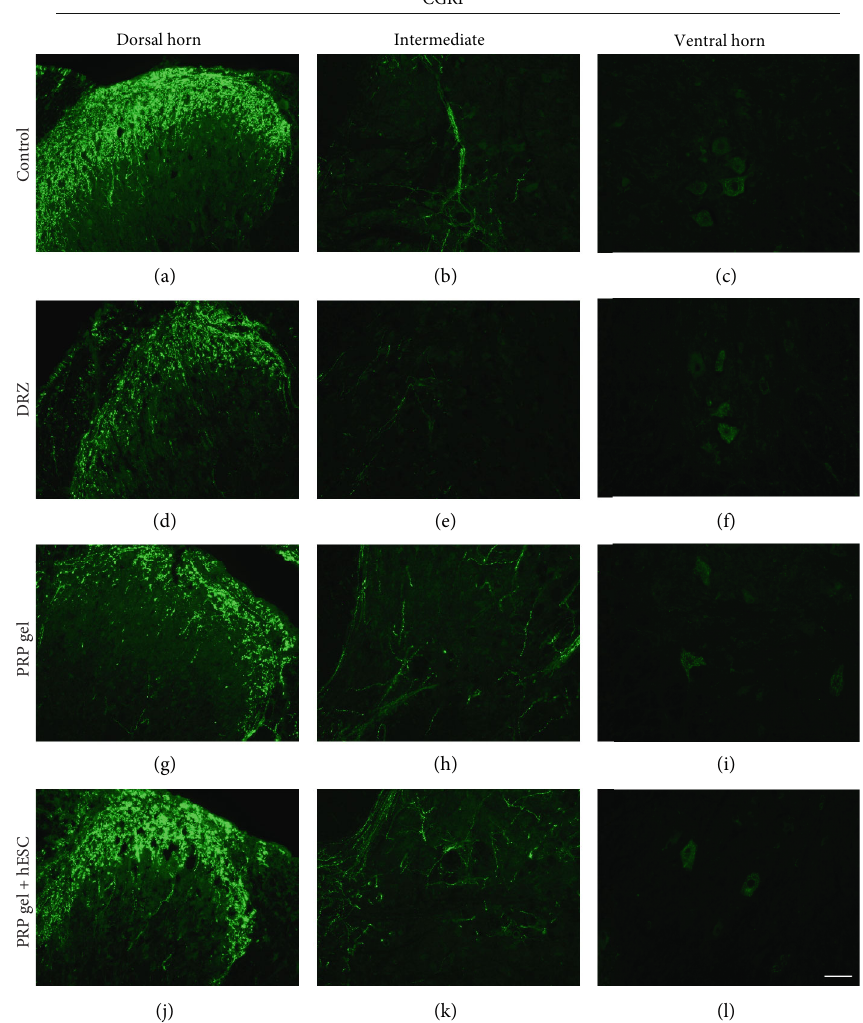
Figure 6: Representative immuno fl uorescence micrographs of CGRP immunolabeling on the ipsilateral side of the spinal cord after rhizotomy and repair, 1 week after lesion. Similar to VGLUT1 immunolabeling, a signi fi cant decrease in CGRP immunoreactivity was observed following DRZ. However, the “ hESC ” group showed a great improvement in CGRP-positive fi bers in comparison to that of the DRZ group. Scale bar = 50 μ m . Table 3: Immunoreactivity related to synaptic vesicles containing the vesicular glutamate transporter type 1 (VGLUT1) (ipsi/contralateral ratio) was obtained by measuring the integrated density of pixels in the spinal cord in III, V, and VI and IX laminae, 1 week after rhizotomy and repair of dorsal nerve roots ( mean ± standard error of mean ). Laminae Control DRZ PRP gel hESCs + PRP